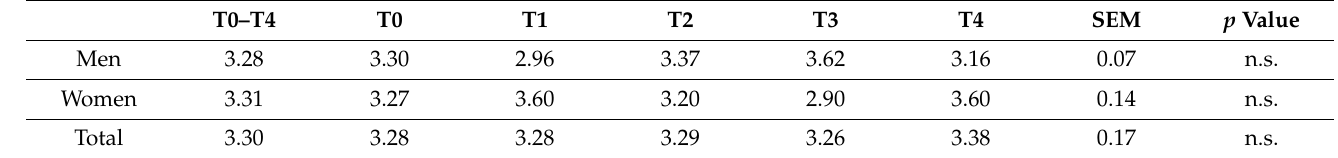
Table 5. Effect of tannin supplementation on sensory evaluation of odour.